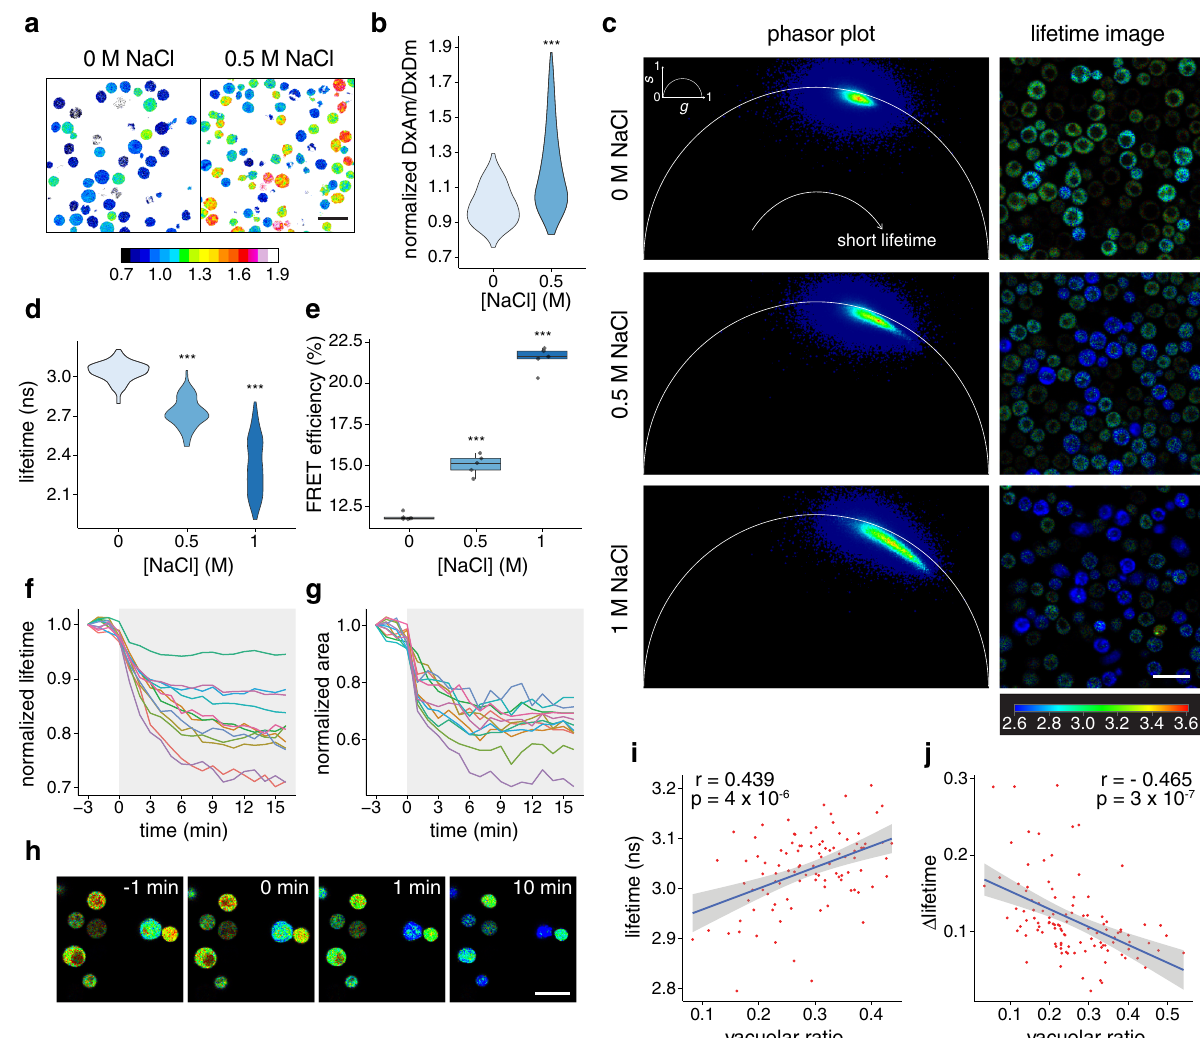
Fig. 4 Tracking SED1 response to osmotic stress in single cells reveals vacuoles buffer against water loss. a Ratiometric image of live yeast cells expressing SED1 under 0 M and 0.5 M NaCl. Scale bar = 10 μ m. Calibration bar represents the normalized FRET ratio (DxAm/DxDm). b Quanti fi cation of ( a ). n = 40 cells (0 M NaCl) and n = 67 cells (0.5 M NaCl). Two-sided Student ’ s t test. *** p = 1 ×10 − 15 . c Phasor plots (left) and donor fl uorescence lifetime images (right) of live yeast cells expressing SED1 under 0 M, 0.5 M, and 1 M NaCl. Signals shifted to the left side of the phasor plot represent longer fl uorescence lifetimes, whereas signals shifted to the right side represent shorter fl uorescence lifetimes. Scale bar = 10 μ m. Calibration bar represents the donor fl uorescence lifetime in nanoseconds (ns). d Quanti fi cation of the donor fl uorescence lifetime of individual cells from images in ( c ). n = 100 cells per treatment. One-way ANOVA. *** p < 2 ×10 − 16 . e FRET ef fi ciencies of live yeast cells from images in ( c ). n = 5 images for each treatment. One-way ANOVA. *** p < 1 ×10 -11 . Boxes represent 25th – 75th percentile (line at median) with whiskers at 1.5*IQR. f Normalized donor fl uorescence lifetime measured for single cells after 1 M NaCl treatment (shaded area) in a time course. The experiment was repeated 3 times with similar results. g Normalized area measured for single cells after 1 M NaCl treatment (shaded area) in a time course (same cells as in ( f )). The same color represents the same cell for ( f ) and ( g ). The experiment was repeated 3 times with similar results. ( h ) Individual time frames showing the donor fl uorescence lifetime of single yeast cells exposed to 1 M NaCl treatment at time 0 min. Scale bar = 10 μ m. The calibration bar is the same as in ( c ). The experiment was repeated 3 times with similar results. i Pearson ’ s correlation of donor lifetime and vacuolar ratio values for single yeast cells under standard conditions (0 M NaCl). Pearson ’ s correlation coef fi cient r = 0.439, p -value = 4 ×10 − 6 . Continuous line was smoothed using R with a linear method smoothing function. Shaded region indicates 95% con fi dence interval. j Pearson ’ s correlation of the change in donor lifetime ( Δ lifetime) and vacuolar ratio values for single yeast cells subjected to 1 M NaCl. Δ lifetime = ( fi nal lifetime − initial lifetime)/initial lifetime. Pearson ’ s correlation coef fi cient r = − 0.465, p -value = 3 ×10 − 7 . Continuous line was smoothed using R with a linear method smoothing function. Shaded region indicates 95% con fi dence interval. Source data are provided as a Source Data fi fl uorescence lifetime of the donor is effectively decreased when it To further con fi rm that the response of SED1 to hyperosmotic undergoes FRET with the acceptor 35 . AtLEA4-5 fused to stress was caused by bona fi de donor-to-acceptor FRET, we performed fl uorescence lifetime imaging-FRET (FLIM-FRET) mCerulean3 (donor-only control) expressed in yeast cells under experiments. FLIM is not sensitive to fl uctuations in biosensor concentration, shading, excitation intensity, or background noise 3.62 ± 0.10 nanoseconds (ns) (Supplementary Fig. 6). The average fl uorescence lifetime of mCerulean3 in the SED1 construct under caused by the light source 35 . In FLIM-FRET experiments, the